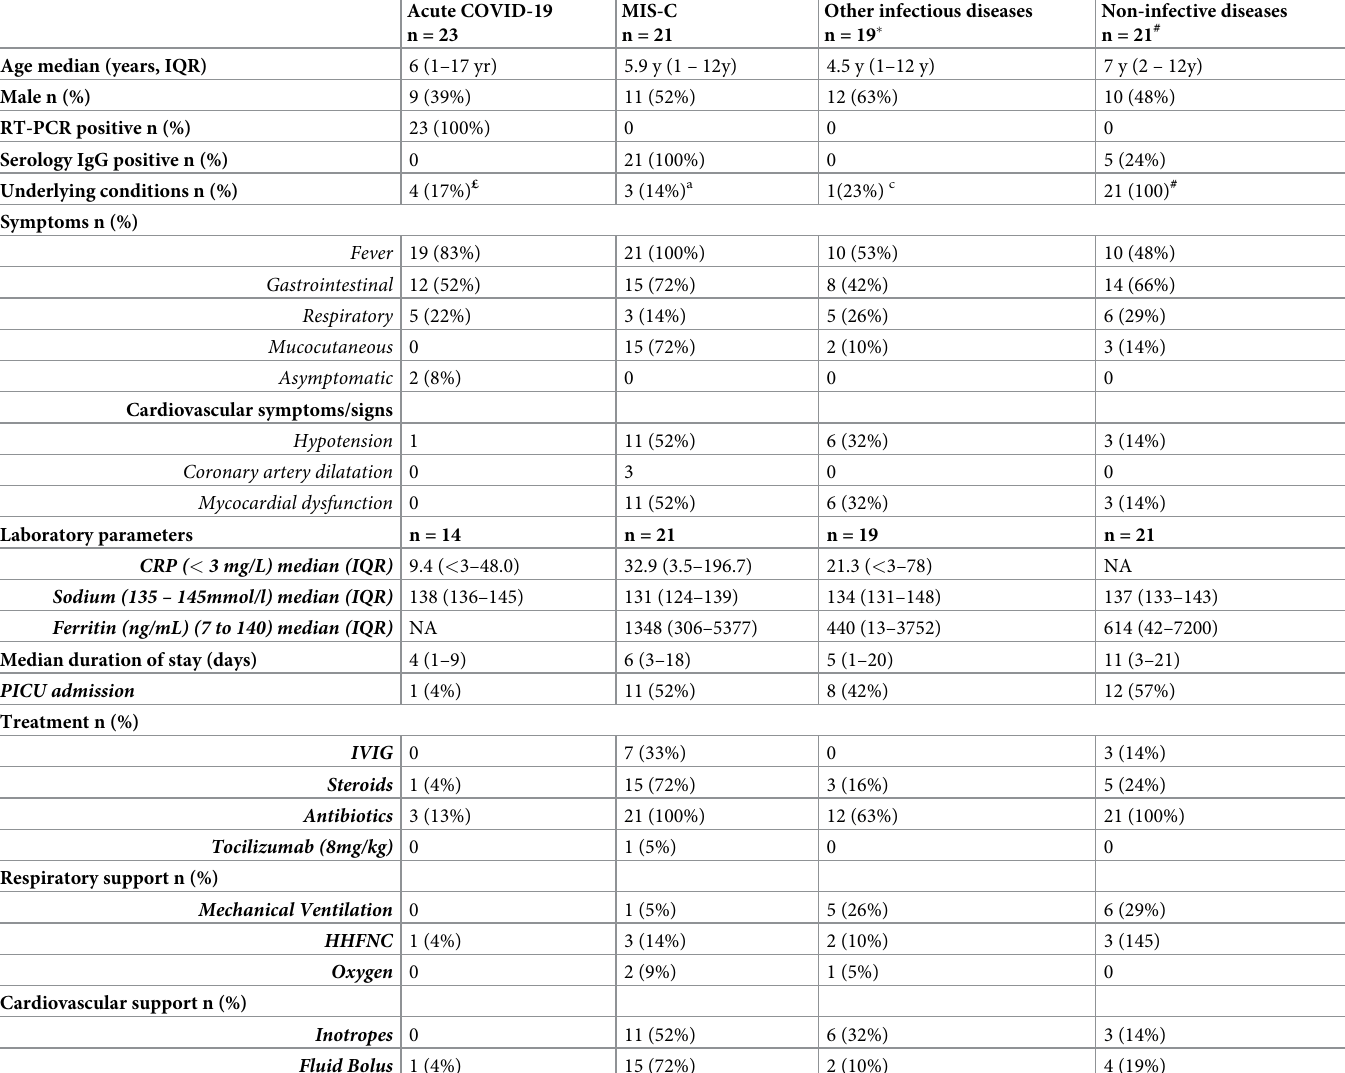
Table 1. Characteristics of the study